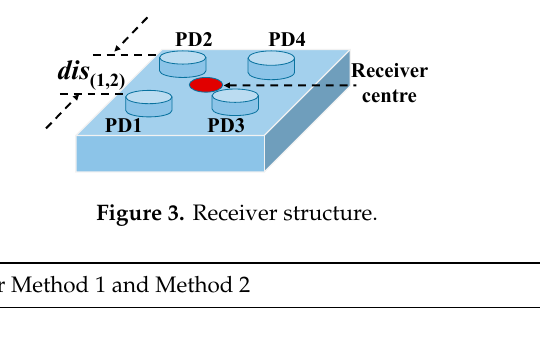
Figure 2. Schematic diagram of the reinforcement learning mechanism in the 3D VLP system. Sensors 2020 , 20 , x FOR PEER REVIEW